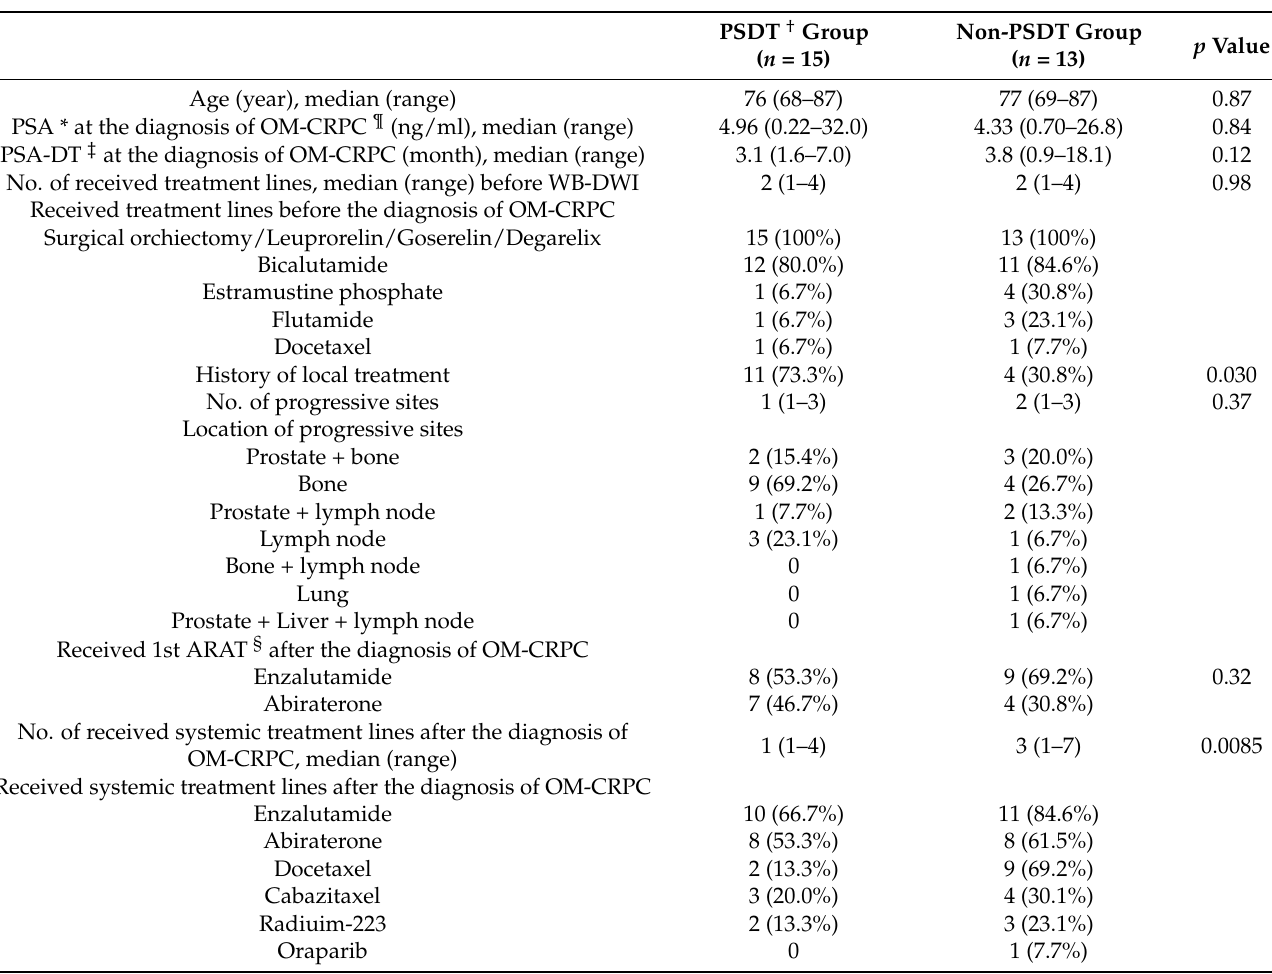
Table 1. Patient and treatment characteristics of oligometastatic castration-resistant prostate cancer patients treated with an androgen receptor-axis-targeted drug.